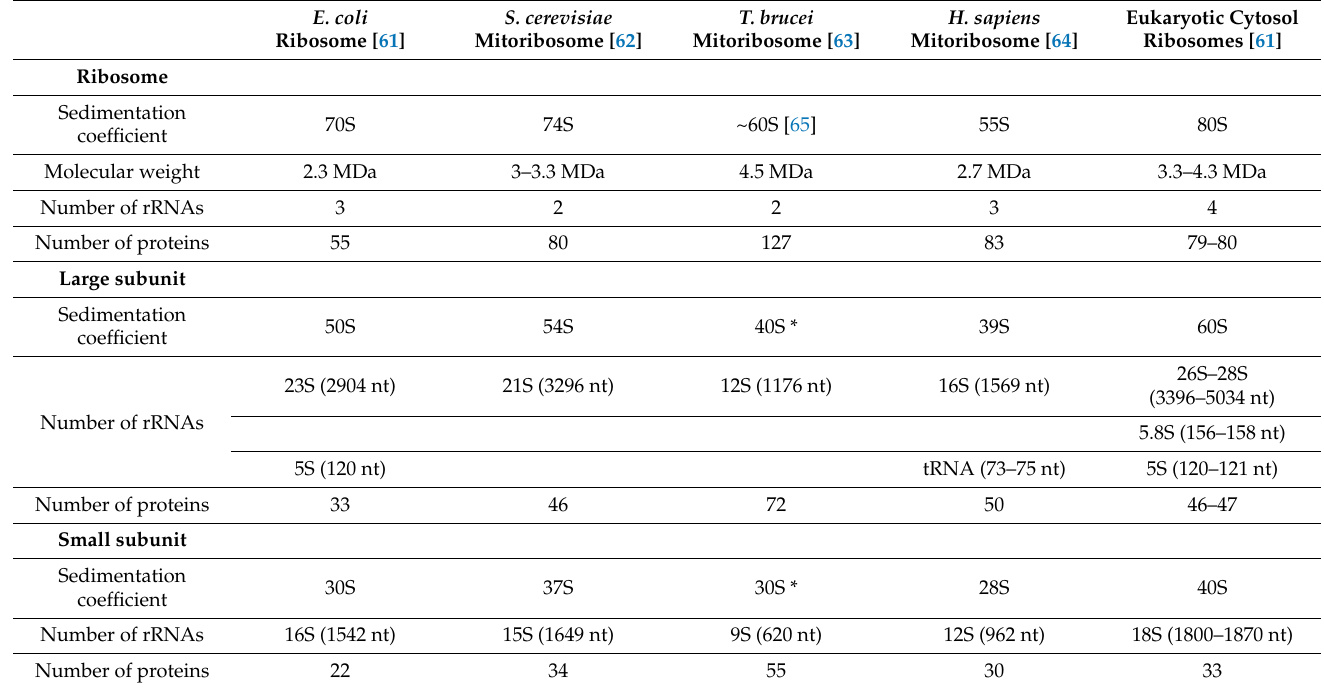
Table 1. Composition of cytosolic and mitochondrial ribosomes in different